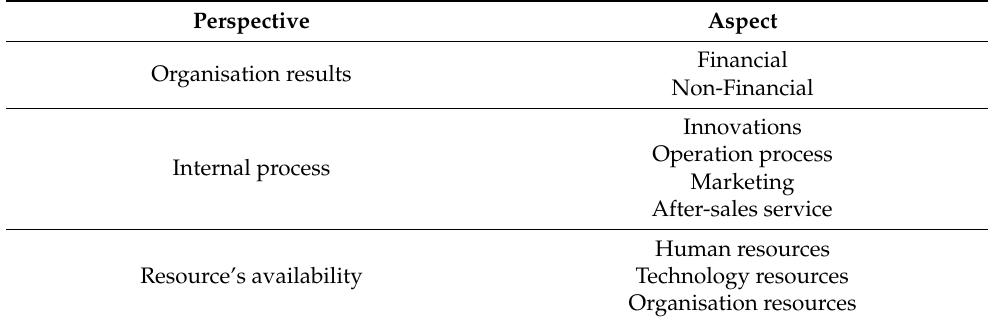
Table 1. Perspectives of an Integrated Performance Management system